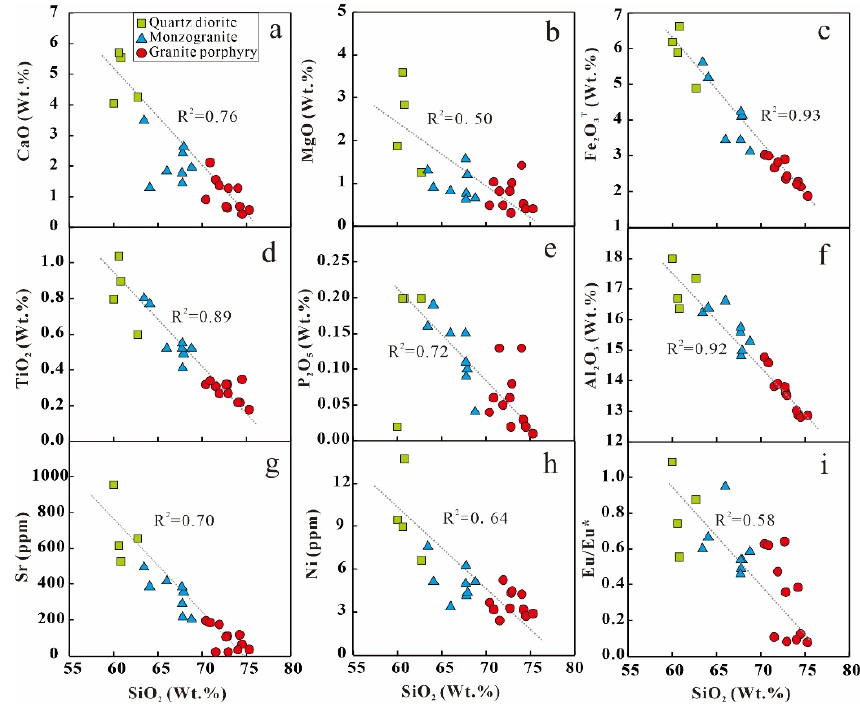
Figure 7. Harker diagrams for the granitoids from Zalute. SiO 2 versus CaO ( a ); MgO ( b );